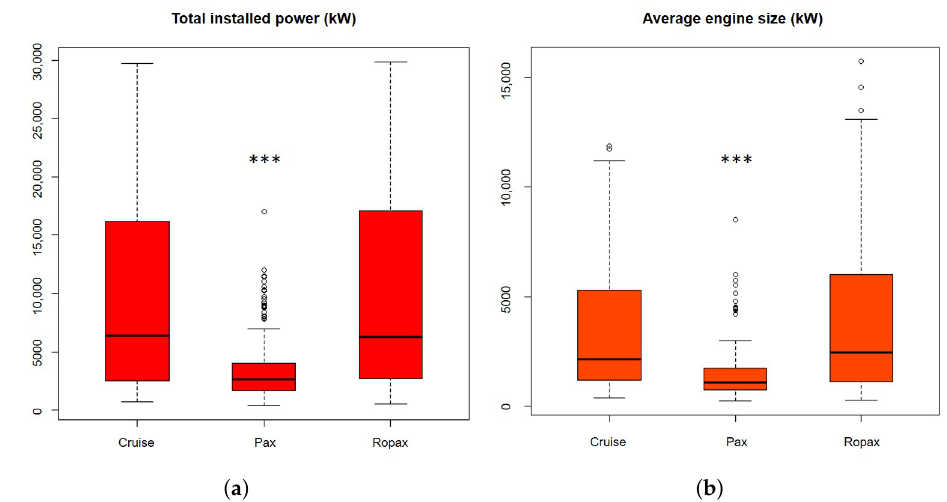
Figure 1. Boxplots of ( a ) Total nominal power installed (Wicoxon; p < 0.001 for Pax vs. Cruise and Pax vs. Ro-Pax) and ( b ) Average engine size (Wicoxon; p < 0.001 for Pax vs. Cruise and Pax vs. Ro-Pax). *** for p < 0.001 vs Cruise and vs Ro-Pax.